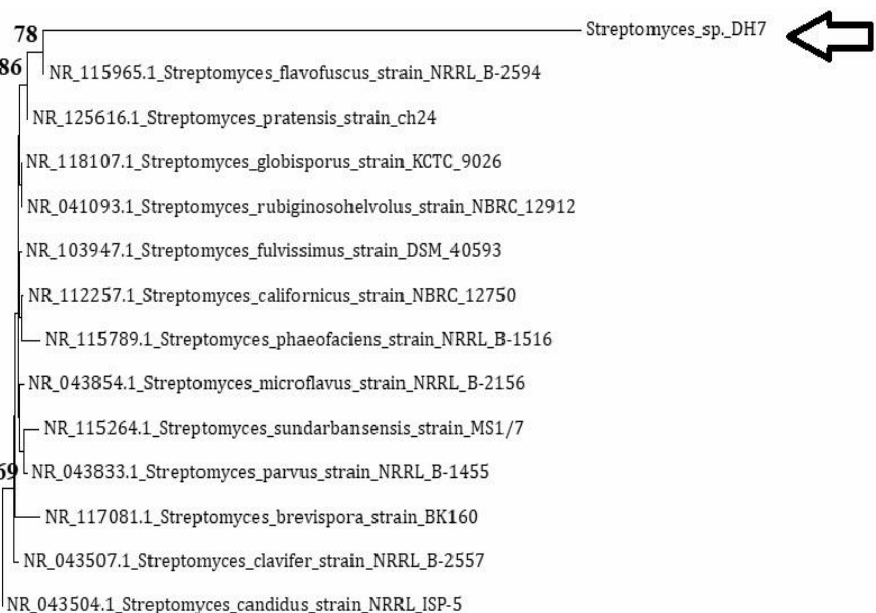
Figure 2. NJ-phylogenetic tree based on partial 16S rRNA gene sequences of Streptomyces sp. DH7 and other Streptomyces species. Phylogenetic analysis was conducted using the CLUSTAL W pro- gram and the neighbor-joining phylogenetic tree was constructed using Molecular Evolutionary Genetics Analysis (MEGA) software version